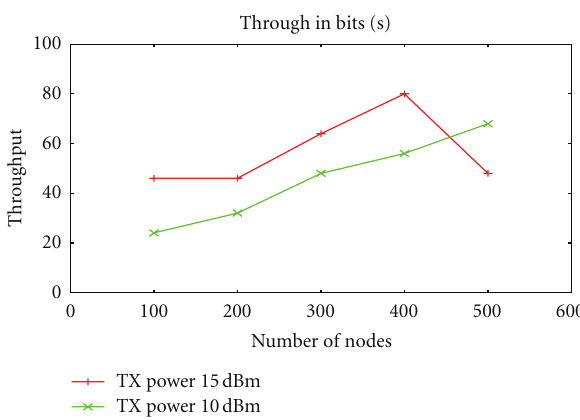
Figure 3: Number of nodes versus throughput.